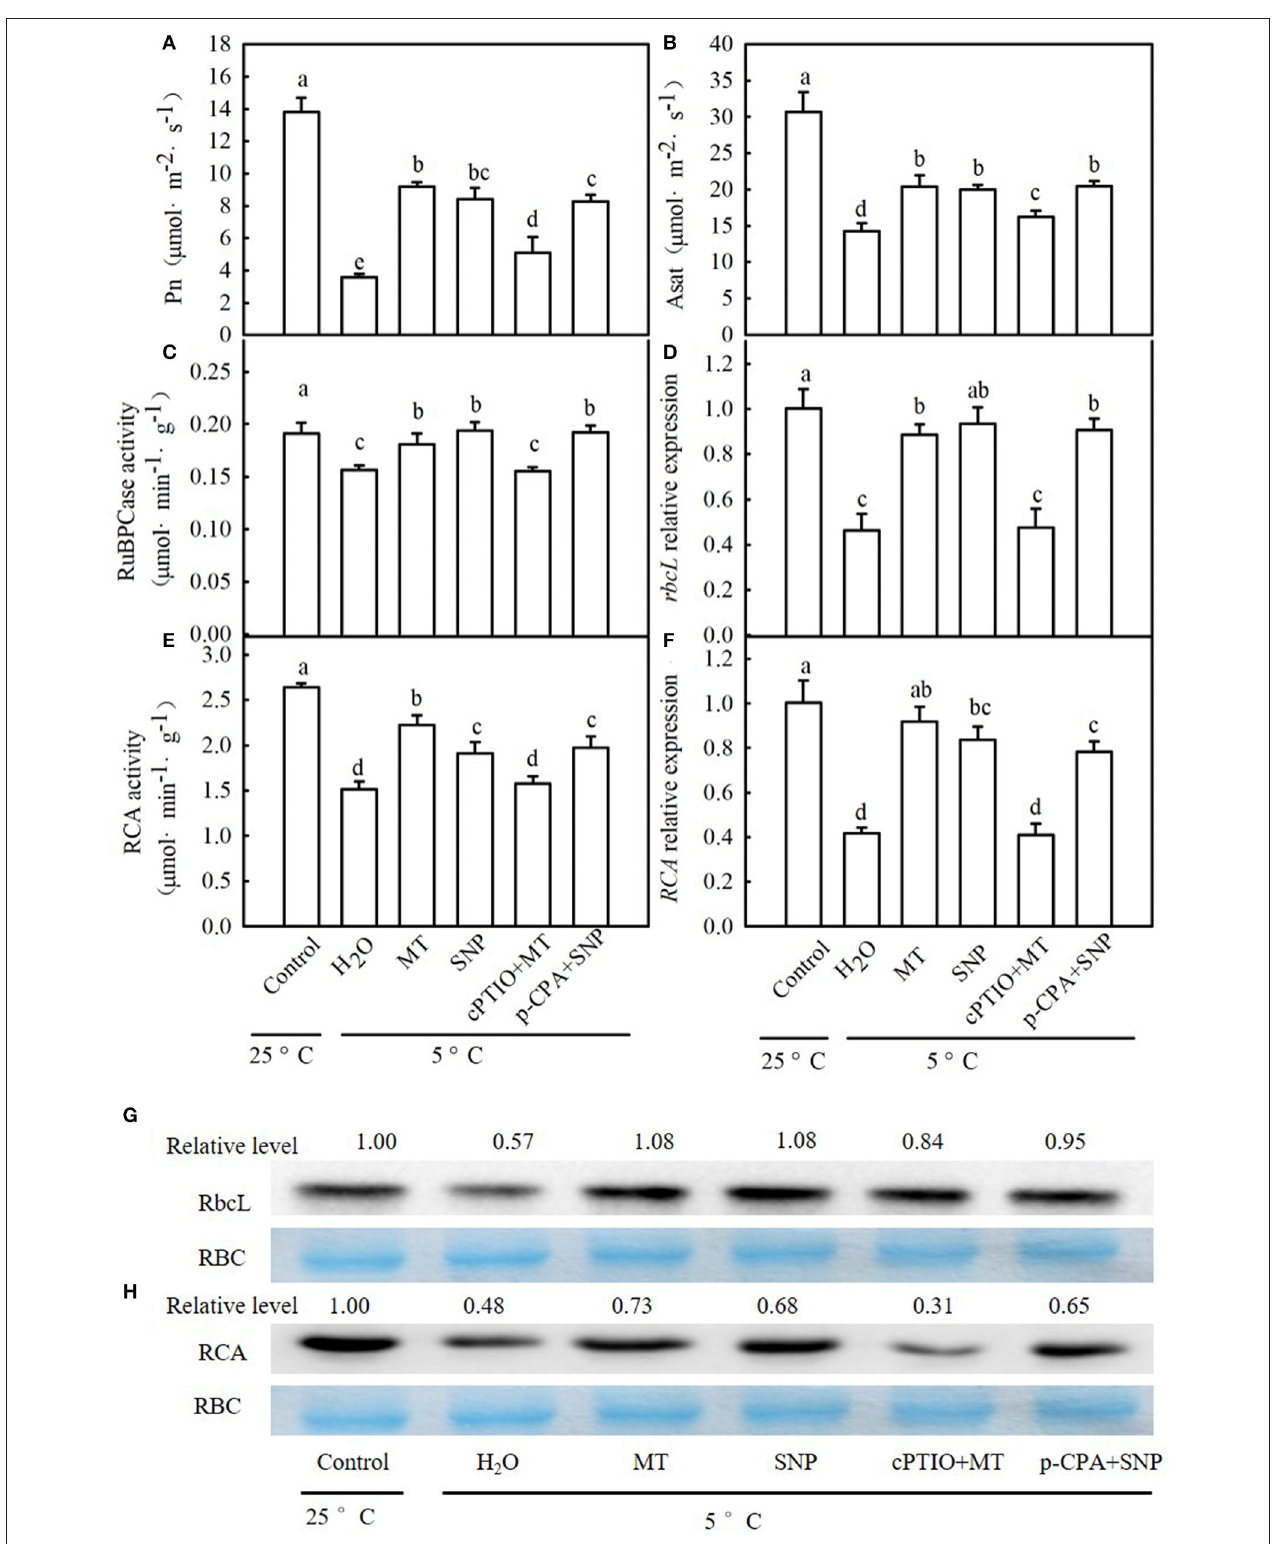
FIGURE 10 | Interactive effects of MT and SNP on P n , A sat, activity of Ribulose-1,5-bisphosphate carboxylase (RuBPCase) and Rubisco activase (RCA), and relative expression of rbcL and RCA in mRNA and the protein level in cucumber seedlings under cold stress. (A) P n , (B) A sat ; (C,D) activity of RuBPCase and